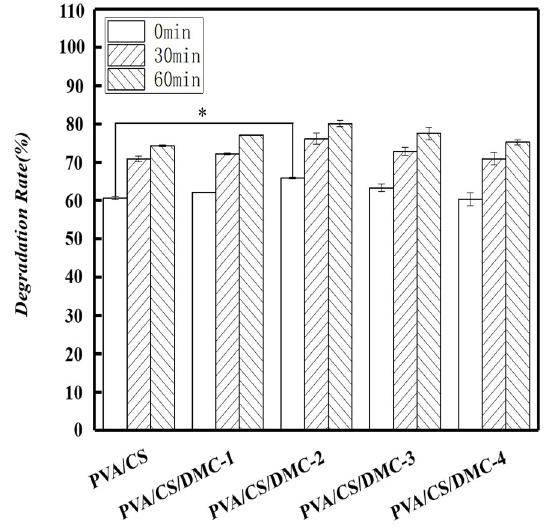
Figure 8. Degradation rate of different composite films in the case of varying ultrasonication time. a Values marking various superscripts for every parameter within the same ultrasound times differ noticeably ( p < 0.05).